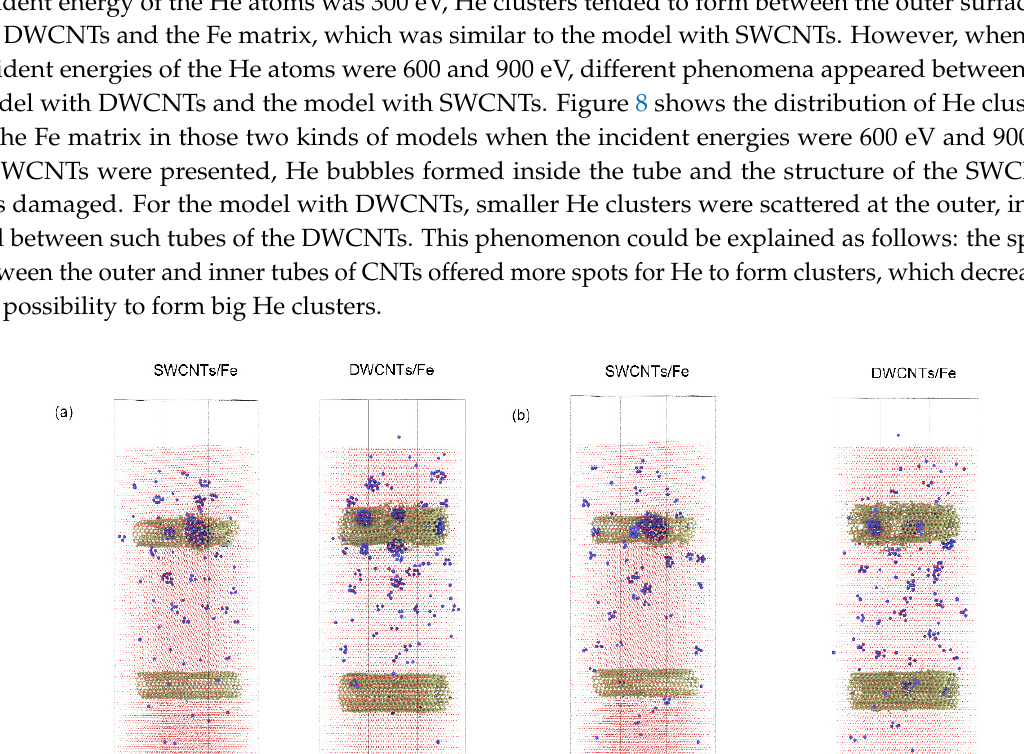
Figure 9. The number of He clusters in SWCNT/Fe and DWCNT/Fe composites, t = 1400 ps. The incident energies of the He atoms were ( a ) 300 eV; ( b ) 600 eV; and ( c ) 900 eV. 4. Conclusions The kinetics of He irradiation on both bcc-Fe and CNT/Fe composites under low incident energy was studied by molecular dynamics simulations. The results showed that the small (3 ≤ n < 10) and